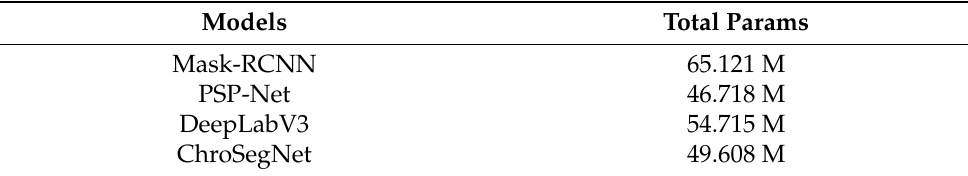
Table 4. Comparison of parameters of different models and